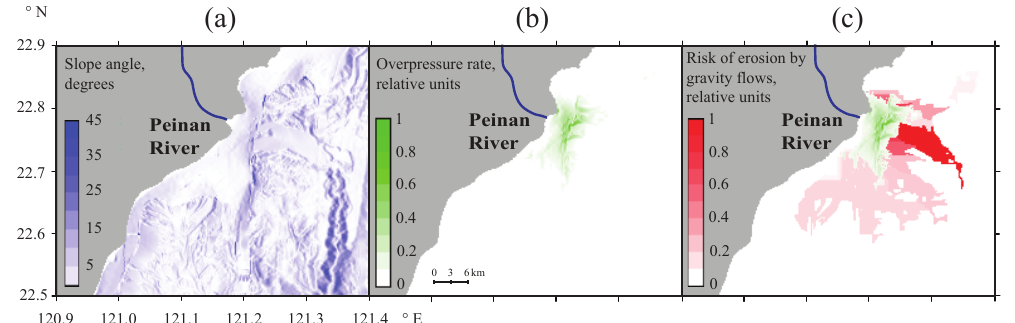
Figure 9. Bottom topography gradient at the region of numerical modeling (a) , distribution of the overpressure rate (b) after typhoon conditions and potential paths of the related gravity flows (c)